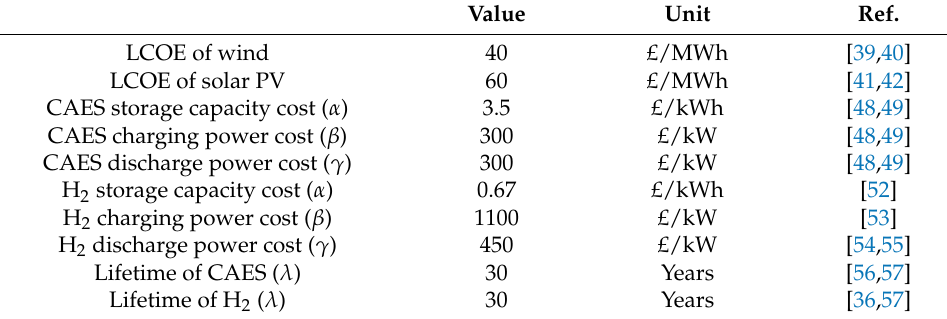
Figure 15. Effect of the ratio X (mix H 2 + CAES) and the post-split signal optimization on the total cost of electricity. Table 1. Figures used for the calculation of the total cost of electricity.